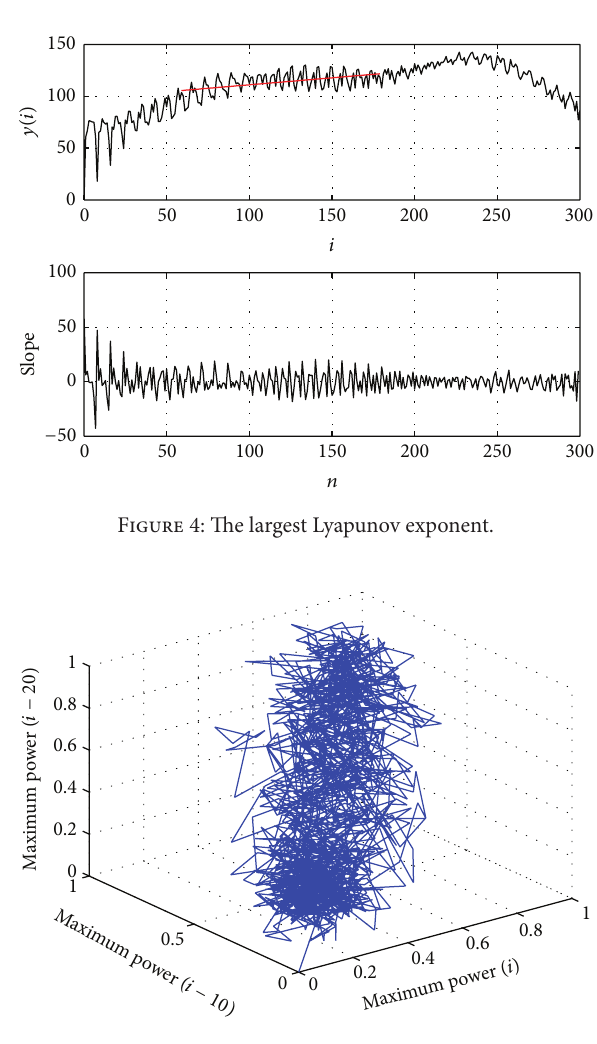
Figure 5: The attractor of chaotic power time